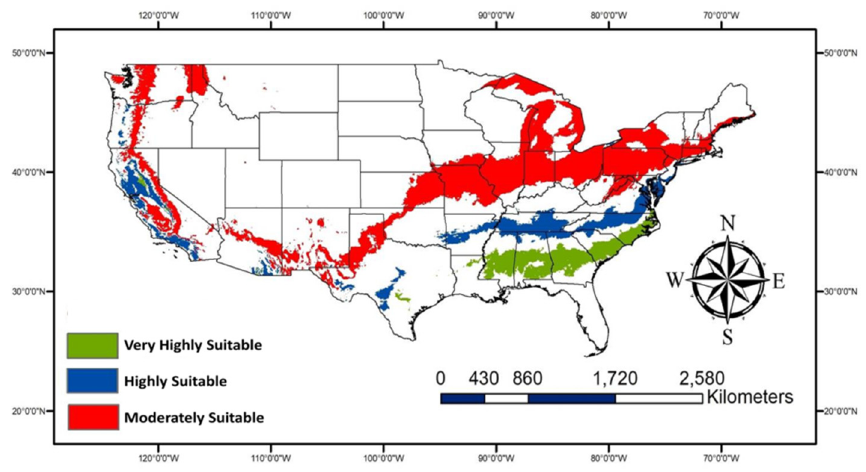
Figure 8. Map showing gain areas due to climate change for three suitability classes.